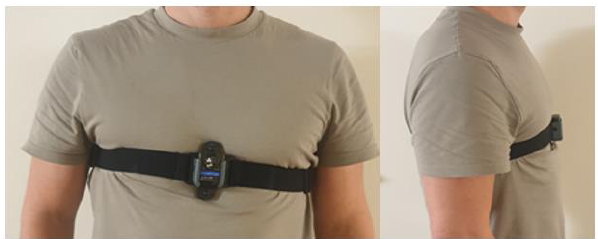
Figure 1. Placement of the inertial measurement unit on the body as described in Warmerdam et al., (2021) [31].